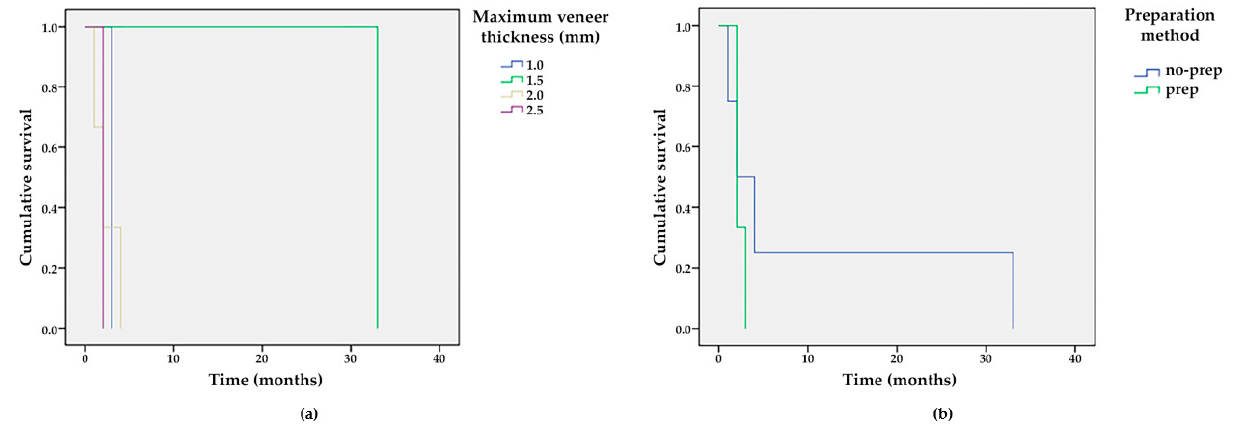
Figure 10. Survival functions for different ( a ) veneer thicknesses and ( b ) preparation